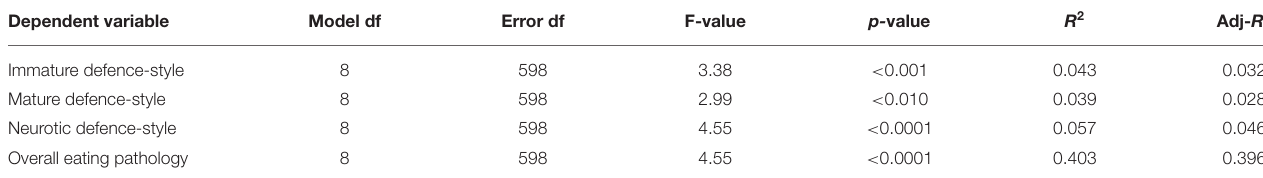
TABLE 2A | Overall F test and fit statistics of the models with eating pathology subscales, quality of life & demographic factors predicting defence-styles. Dependent